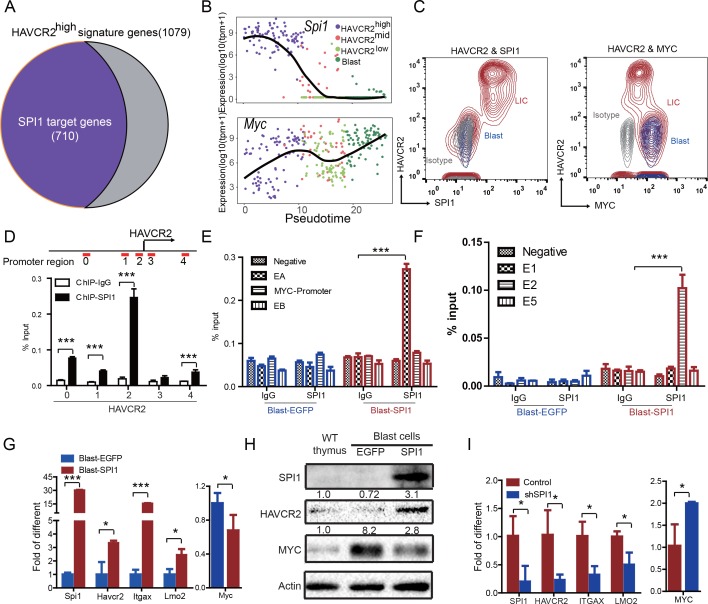
SPI1 is the master regulator of LSC signature genes and controls HAVCR2 and c-MYC expression.(A) Nearly 70% of the genes highly expressed in the HAVCR2high subgroup—the LSC signature genes—are potential SPI1 target genes (purple);(B) Pseudotemporal ordering of single cells based on Spi1 or Myc expression; (C) FACS analysis shows the correlation of HAVCR2 cell surface expression and intracellular SPI1 and c-MYC levels in the LSC-enriched (Lin-CD3+KITmid; red) and blast (Lin-CD3+KIT-; blue) subpopulations. Gray, isotype control; (D–E) ChIP-qPCR analysis identifies SPI1 binding regions in the HAVCR2 promoter (left) and Tcra/d enhancer A(EA) region (right), using Blast-SPI1 cells; (F) ChIP analysis identifies a SPI1 binding site in the endogenous Myc enhancer;(G) q-PCR shows the fold changes in Havcr2, Itgax, Lmo2 and Myc expression between Blast-SPI1 cells (red) and Blast-EGFP cells (blue); (H) Western blotting shows the SPI1, HAVCR2 and c-Myc protein levels in WT thymus, Blast-EGFP and Blast-SPI1 cells. The fold changes relative to expression in the WT thymus are shown above each lane; (I) q-PCR analysis shows the fold changes in HAVCR2, ITGAX, LMO2 and MYC expression in control shRNA (blue) and shSPI1 knockdown human T-ALL KE-37 cells (red); (D–I) All experiments were performed at least three independent times, and the data in D, E, F, G, and I are the means ± S.Ds; *p≤0.05; **p≤0.01; ***p≤0.001.